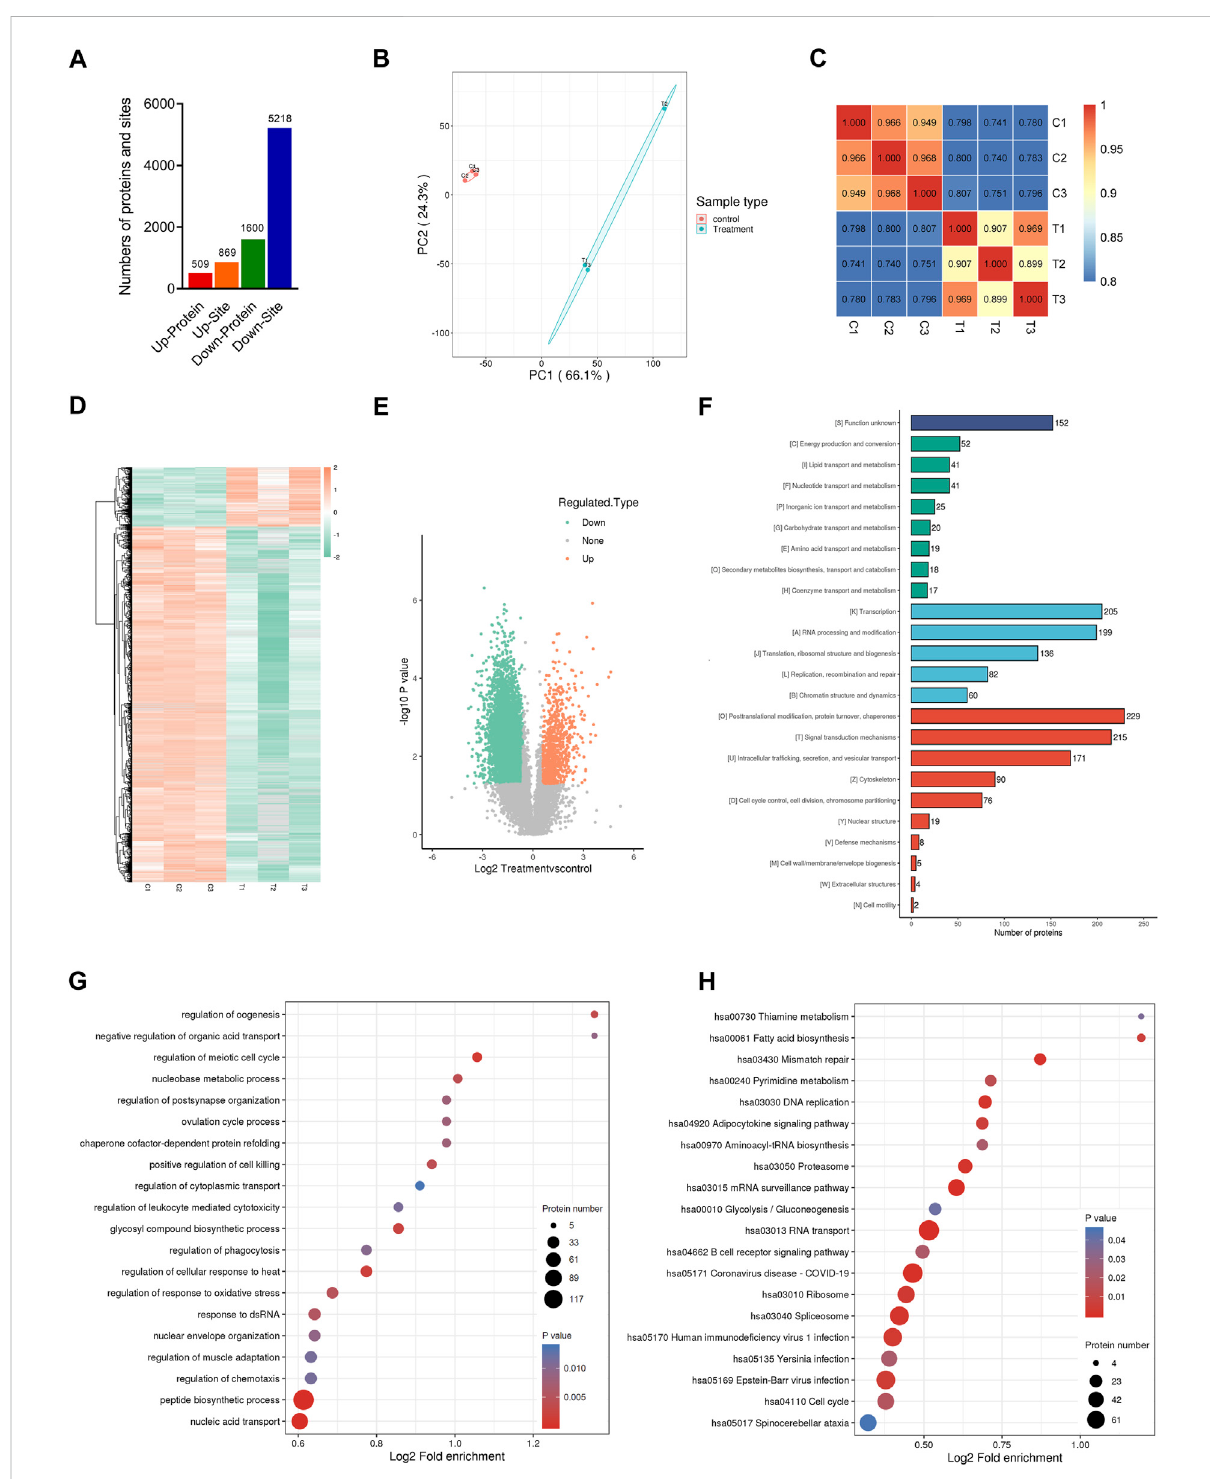
FIGURE 4 QuantitativeubiquitinomeanalysisinCENPF-upregulatedDLBCLcells (A) .Thenumbersofproteinsandsitesidenti fi edbyubiquitinomeanalysis in this study; (B) . The results of principal component analysis in the control group and CENPF-upregulated group identi fi ed by ubiquitinome; (C) . Pearson ’ s correlation coef fi cient analysis performed in different groups; (D,E) . The results of clustering analysis by ubiquitinome analysis are presented as a heatmap and volcano plots (log2-fold change and – log10 p value); (F) . GO analysis and COG/KOG functional classi fi cation of proteins identi fi ed by ubiquitinome analysis; (G,H) . The results of functional enrichment and KEGG enrichment